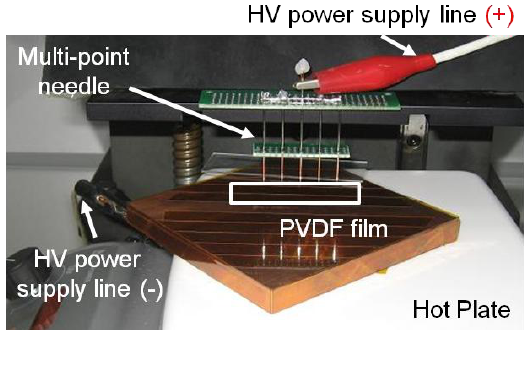
Figure 5. Corona-poling setup to enhance the piezoelectricity of PVDF